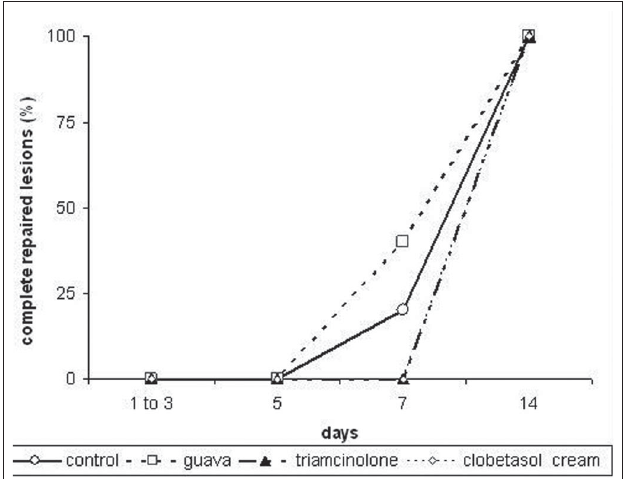
Fig. 2. Clinical evaluation (percentage of repair) of the four experimental